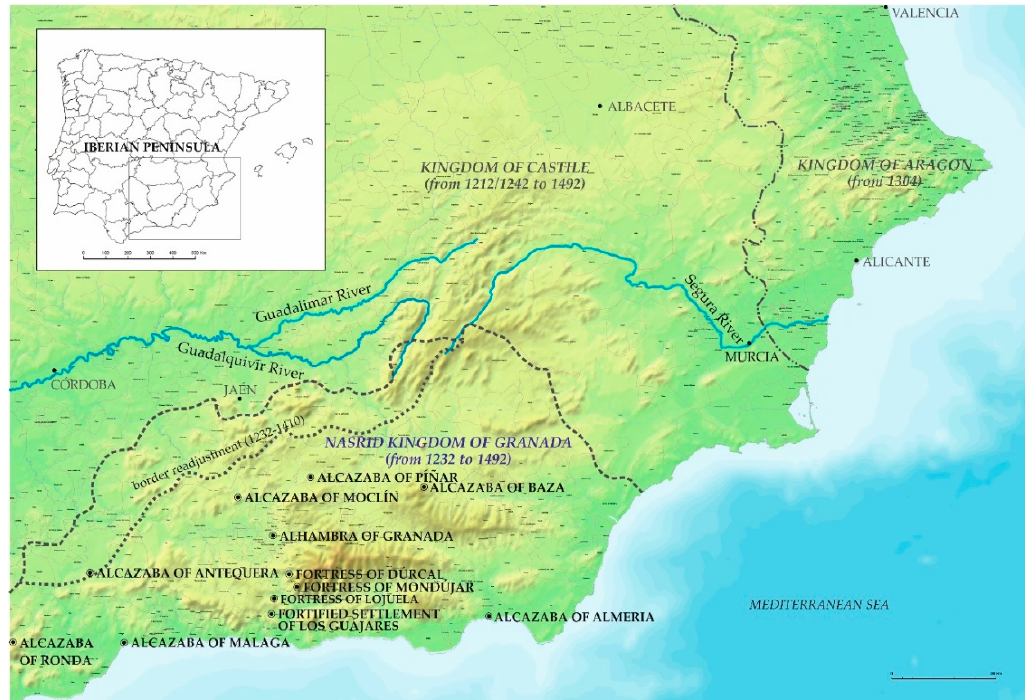
Figure 1. Fortresses studied in relation to their water supply. Created by authors.